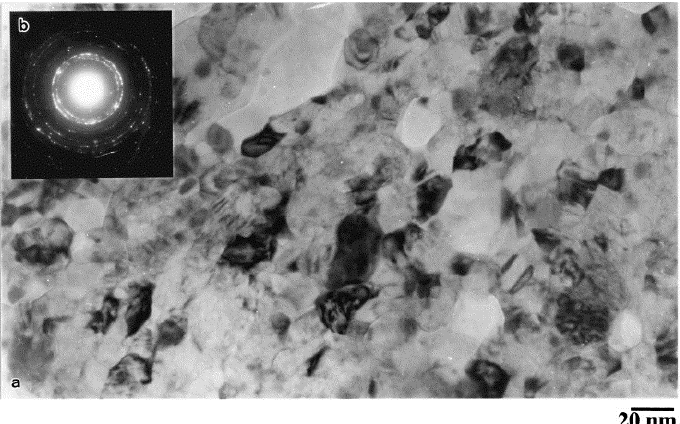
Figure 3. ( a ) BFI and ( b ) the corresponding SADP of as-consolidated mechanically solid state mixed SiC10/Al90 that were ball-milled for 86 ks [35].